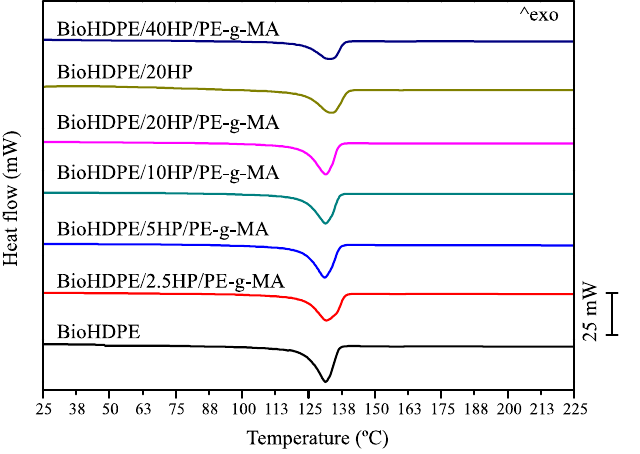
Figure 5. Differential scanning calorimetry (DSC) thermograms of BioHDPE/Hemp fiber composites. Table 3. Main thermal parameters of the composites with different amounts of hemp fiber in terms of melting temperature (T m ), normalized melting enthalpy ( ∆ H m ) and degree of crystallinity ( χ c ). Samples T m ( ◦ C) ∆ H m (J/g) χ c (%) BioHDPE 131.3 ± 0.5